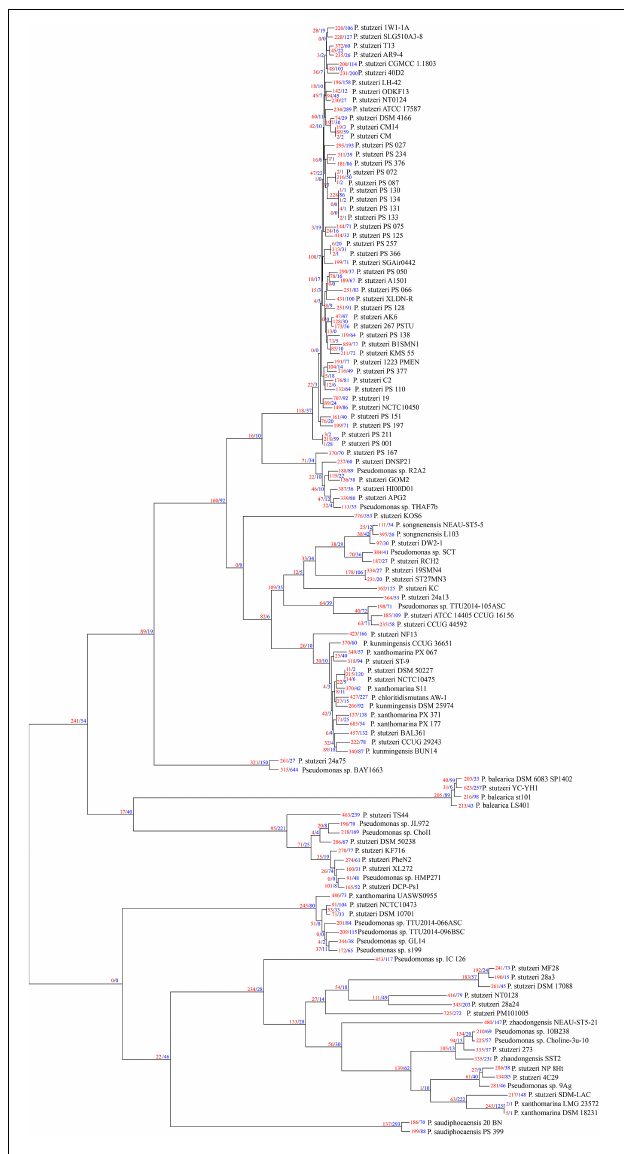
FIGURE 4 | P. stutzeri genome dynamics. Estimated events of genome content evolution were mapped onto the ML phylogenic tree, which was generated by removing the four outgroup strains ( P. aeruginosa DSM 50071 T , P. azotifigens DSM 17556 T , P. mendocina NCTC10897 T and P. putida FF4) of Figure 2 using iTOL. Numbers on branches indicate numbers of genes gained (red) and lost (blue). The tree scale is in the units of the number of nucleotide substitutions per